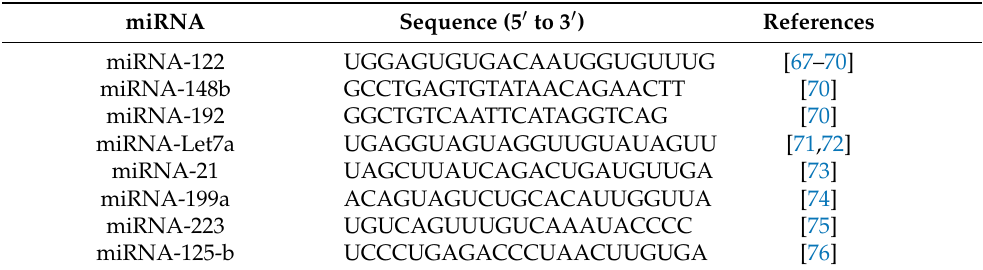
Table 1. Sequences for miRNAs probes contributed to liver cancer. miRNA Sequence (5 (cid:48) to 3 (cid:48)